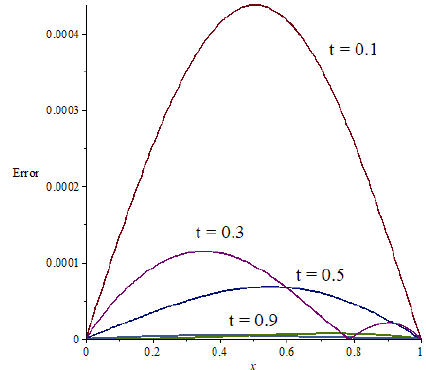
Figure 2. Graph of absolute errors with k = 1, M =